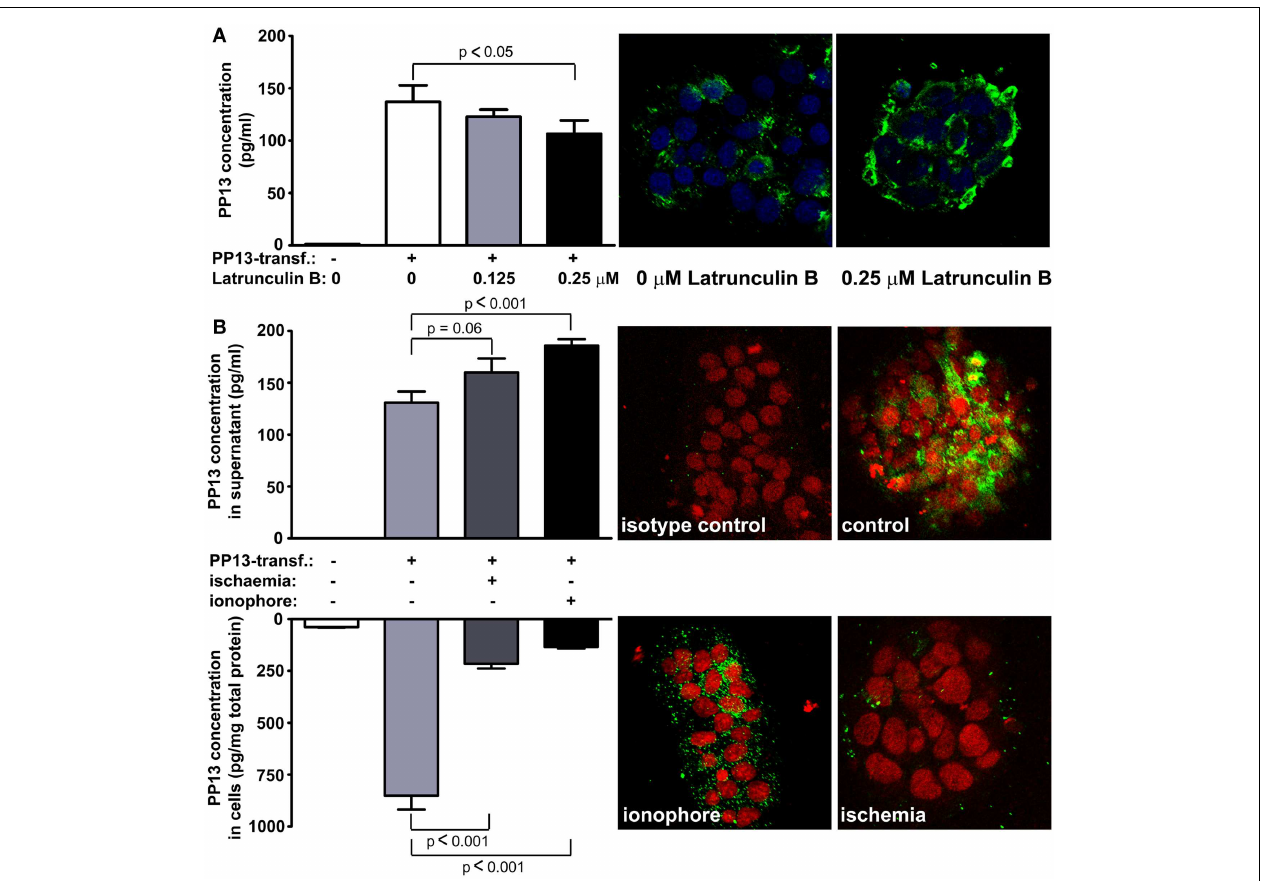
ischemic stress to mimic placental milieu in preterm preeclampsia. (Left) PP13 content of BeWo cells and cell culture supernatants of non-transfected controls, as well as LGALS13 -transfected, untreated, calcium ionophore-treated or ischemia exposed cells were measured by ELISA. (Left) Representative confocal images of LGALS13 -transfected control, calcium ionophore-treated or ischemia exposed BeWo cells immunostained with monoclonal anti-PP13 antibody (green) and counterstained with DRAQ5 (red) nuclei dye. Either ionophore treatment or ischemia induced the release of PP13 from BeWo cells. Figures were published in Ref. (73). Kind permission for the reuse and modification of the figures was obtained from